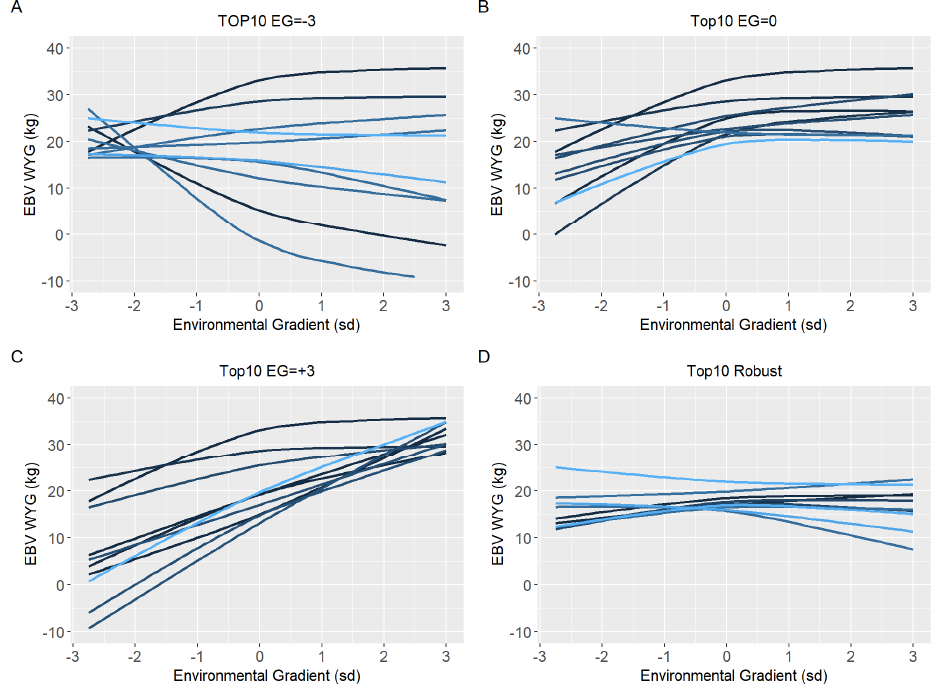
Figure 6. Estimated breeding values (EBV) reaction norms for weaning to yearling weight gain (WYG) of Nellore cattle sires classified as top 10 for low ( A ), medium ( B ), and high environmental gradient ( C ), and top 10 robust ( D ), considering the reaction norm models (RNM) fitted with spline linear–linear heteroscedastic